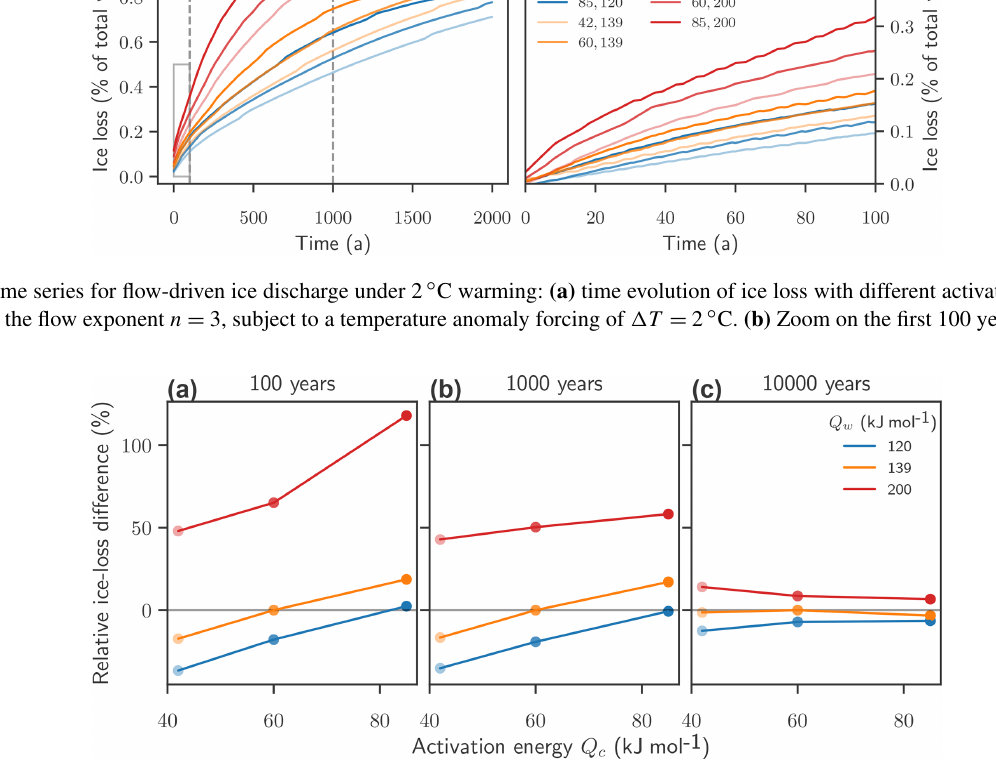
Figure 7. Effect of activation energy on flow-driven ice discharge under 2 ◦ C warming: relative difference of flow-driven ice loss after 100 (a) , 1000 (b) , and 10000 (c) years versus Q c . The value of Q w is given by the color. The simulations have reached a new equilibrium after 10000